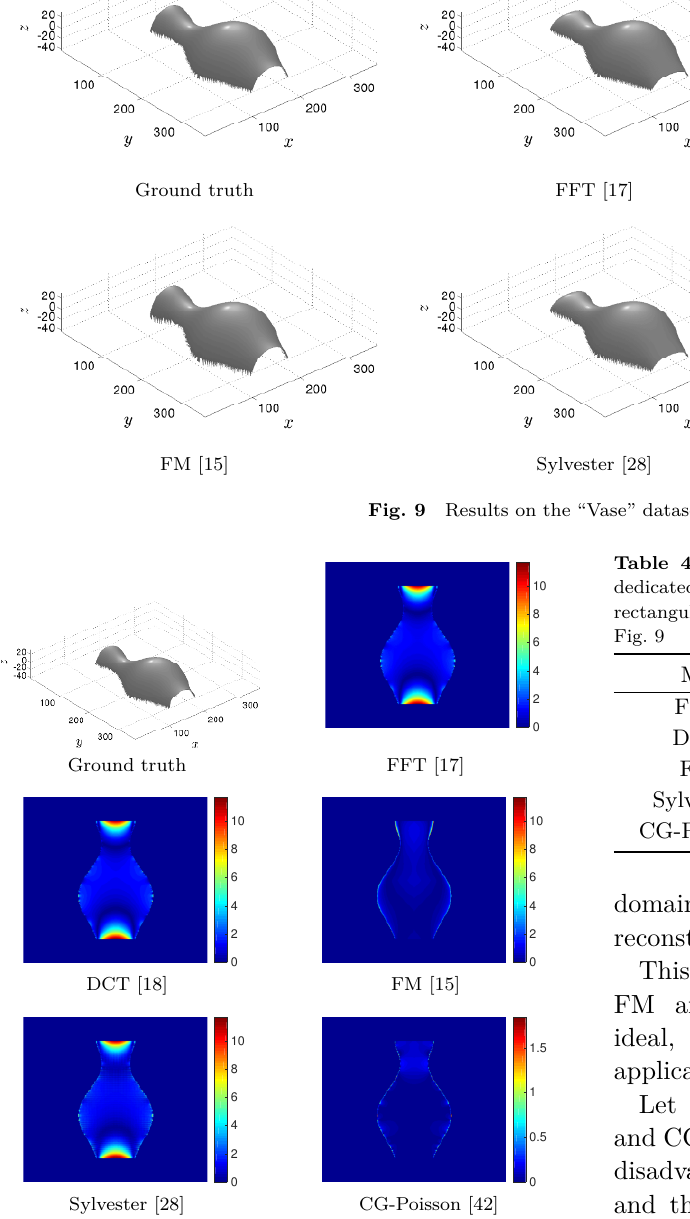
Fig. 10 Absolute errors for the “Vase” dataset between the ground truth and the numerical result of each method; see Table 4. Note the different scales of the plots. To highlight the differences between all methods we use two different scales. The absolute error maps of FFT, DCT, Sylvester, and FM have the same scale due as their maximum errors are very close. For CG we use a different scale to point out the differences.